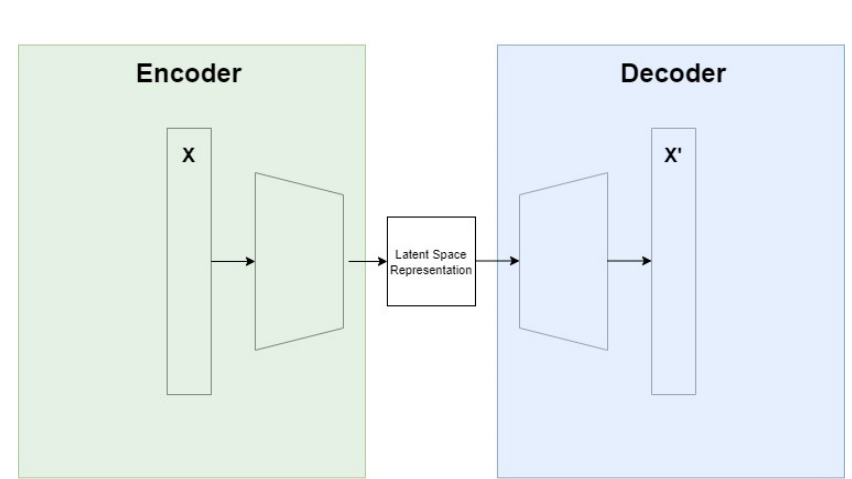
Figure 2. Visualisation of autoencoder operation, modified from [34].